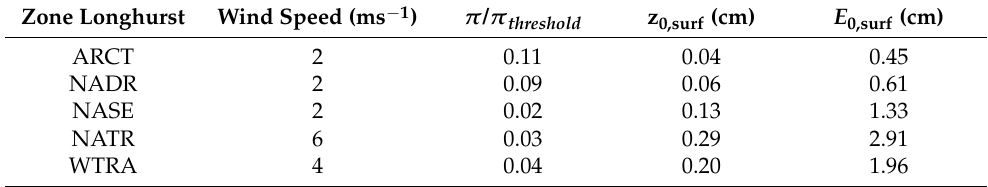
Figure 3. Summer (June/July/August) average chl-a concentration in the North Atlantic. The average was computed from Aqua MODIS data for 2002–2016. The outline of the Longhurst ecological regions identified in Figure 1 is shown. Table 3. Roughness length and elemental height values calculated for each Longhurst region.